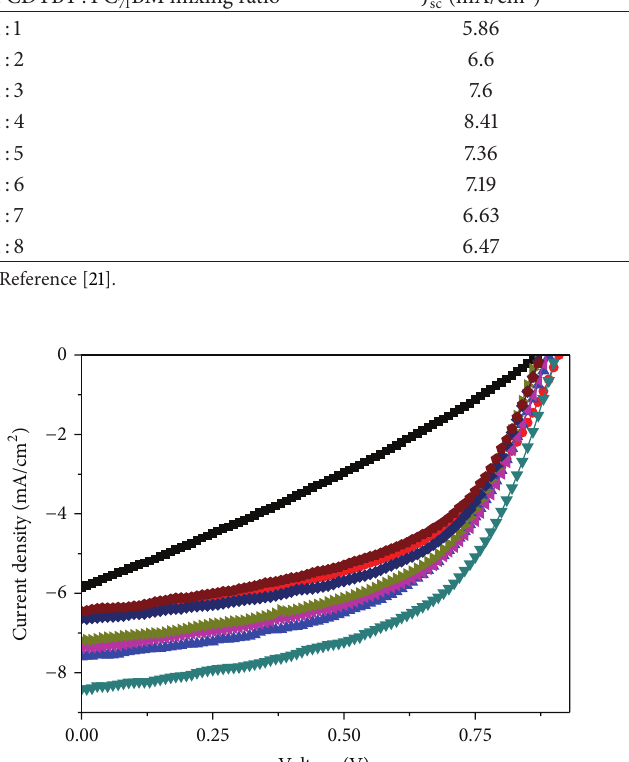
Table 3: 𝐽 - 𝑉 parameters of OTFSCs device with PCDTBT:PC PCDTBT:PC BM mixing ratio 71